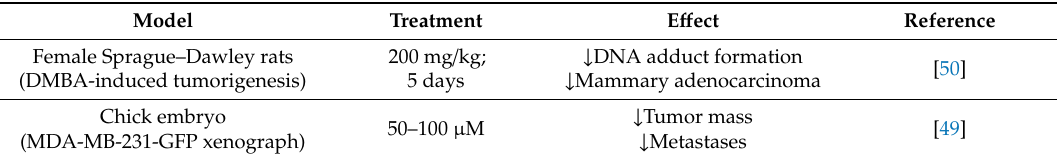
Table 4. E ff ects of carnosol on breast cancer in